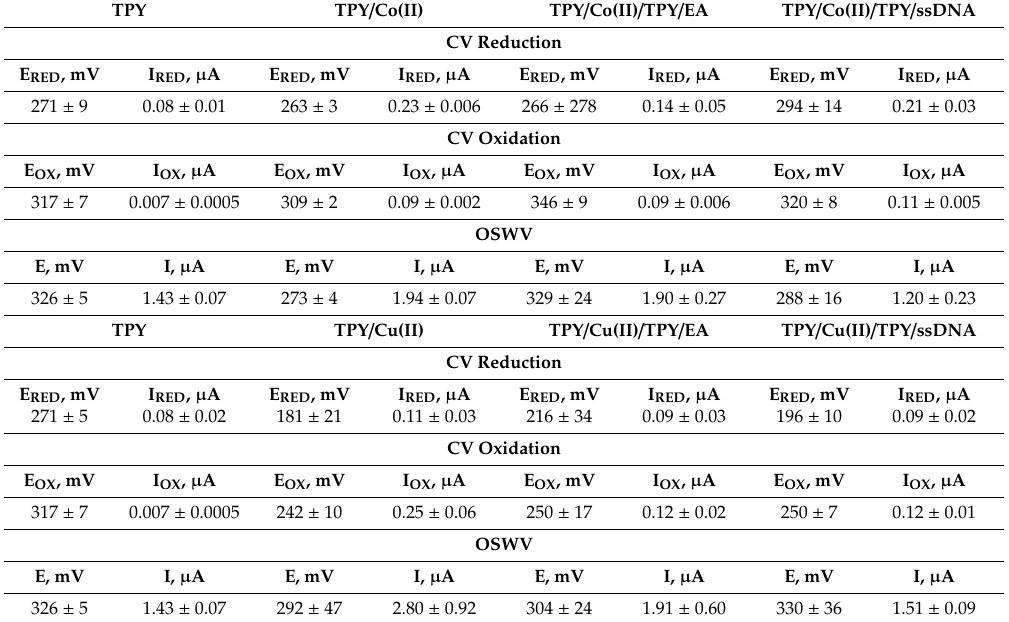
Table 1. Comparison of peak potentials and current values recorded for gold electrodes modified with TPY / M(II) / TPY / EA and TPY / M(II) / TPY /